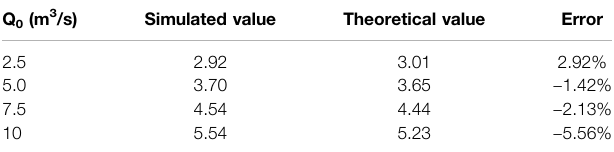
TABLE 2 | Comparison of measured values to values from empirical formulas. Q 0 (m 3 /s)